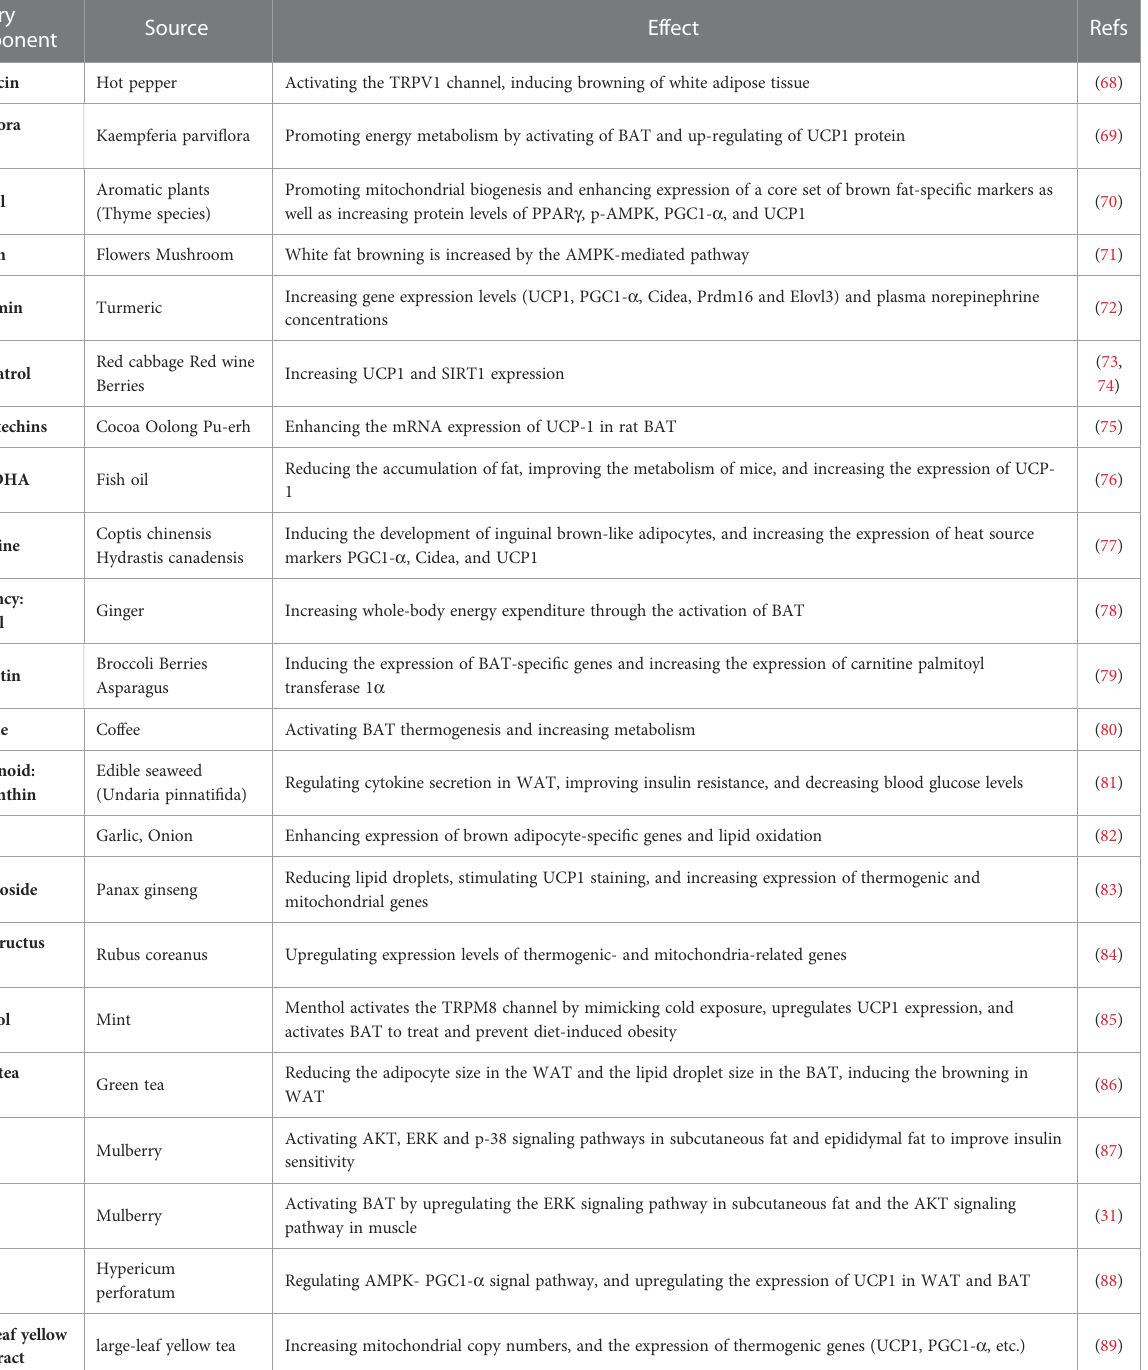
TABLE 1 A dietary compound capable of activating BAT.